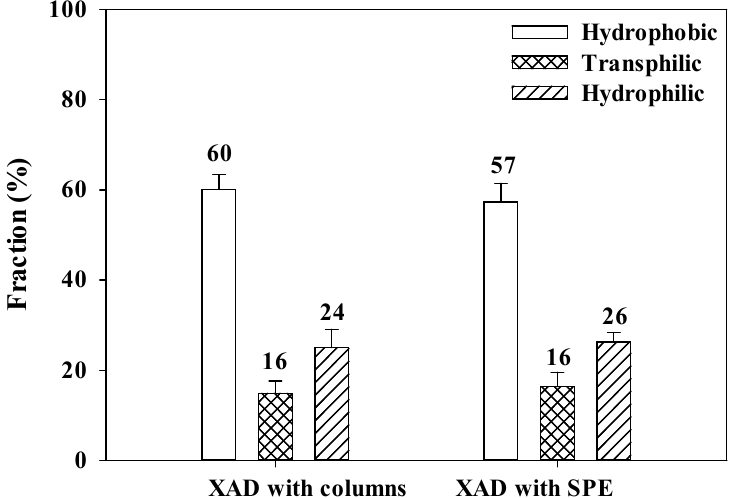
Figure 3. Relative hydrophobicity of AHA determined by combined XAD8/4 isolation with columns and SPE cartridges.